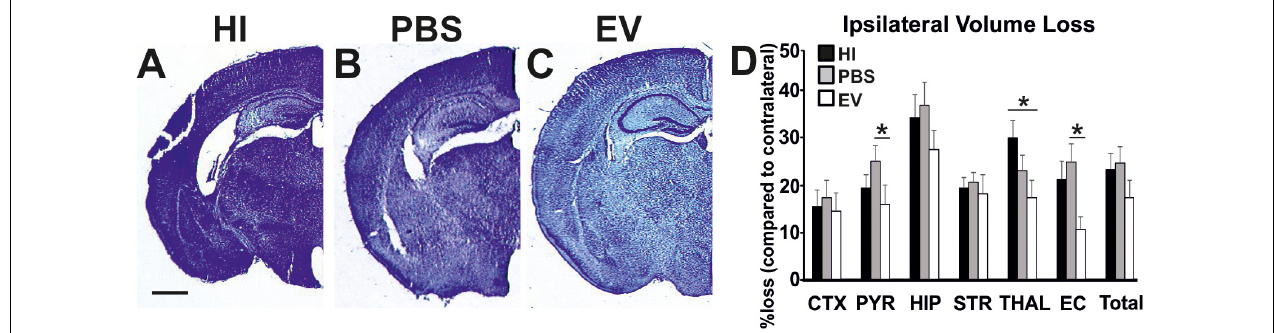
FIGURE 3 | Intranasal application of MSC-derived EVs, immediately following HI, significantly reduces tissue loss after 48 h. Ipsilateral forebrain Nissl staining (Cresyl-Violet, at rostral parietal level) of HI (A) , PBS- (B) , and EV-treated (C) animals and quantification of ipsilateral brain tissue volume loss (D) at 48 h following HI-insult. Intranasal EV treatment reduced volume loss (Mean + SEM) compared to HI and PBS-treated littermates (Kruskal–Wallis test, p = 0.0453) with significant, individual decrease in pyriform cortex (Kruskal–Wallis test, p = 0.0273; Dunn’s test EV vs. PBS ∗ p = 0.0219), thalamus (Kruskal–Wallis test, p = 0.0445; Dunn’s test EV vs. HI ∗ p = 0.0348), and external capsule (Kruskal–Wallis test, p = 0.0114; Dunn’s test EV vs. PBS ∗ p = 0.0126). CTX, cerebral iscocortex; PYR, pyriform cortex; HIP, hippocampus; STR, striatum; Thal, thalamus; EC, external capsule. Scale bars: A–C = 470 µ m.